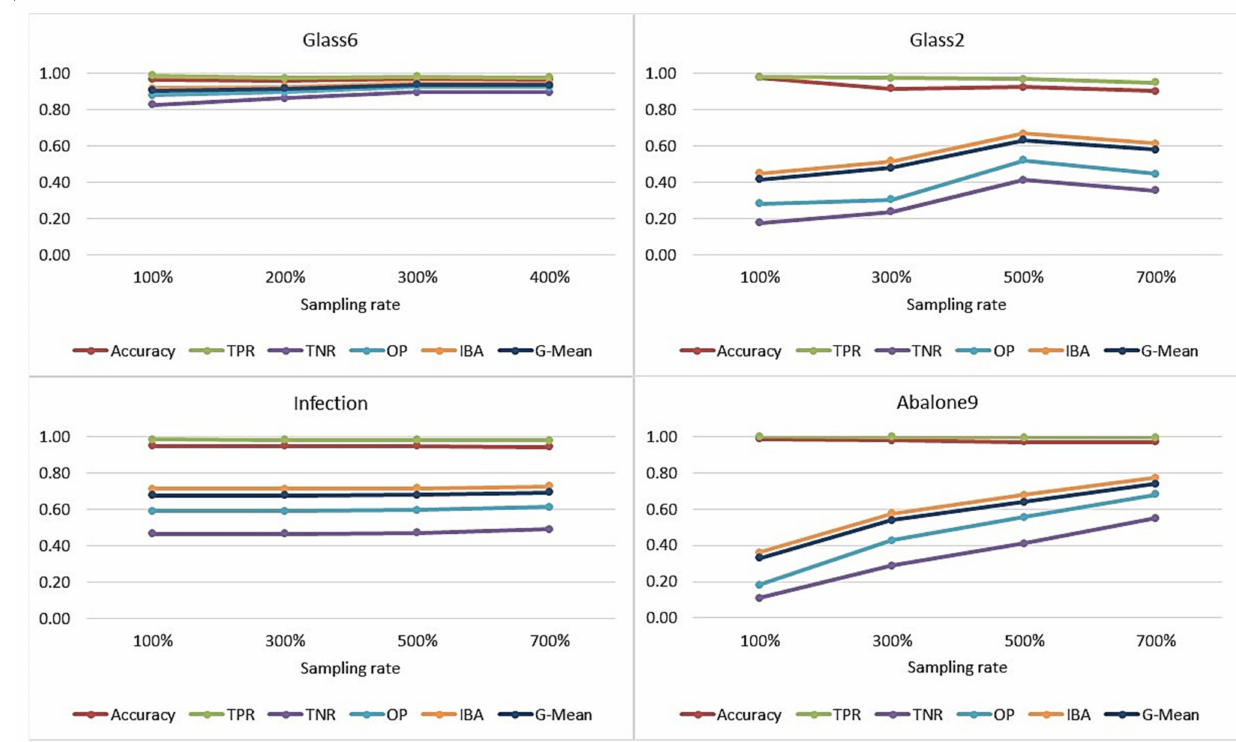
Figure 11. Effect of SMOTE resampling rate on accuracy, TPR, TNR, OP, IBA and G-mean with datasets representative of different